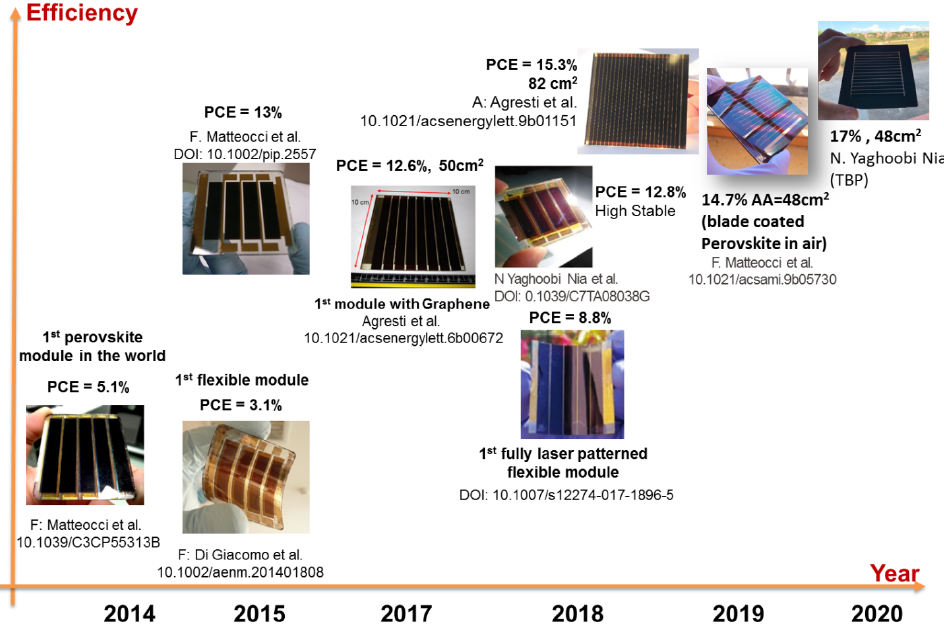
Fig. 19. – Perovskite module development at the Centre for Hybrid and Organic solar Energy (CHOSE), University of Rome Tor